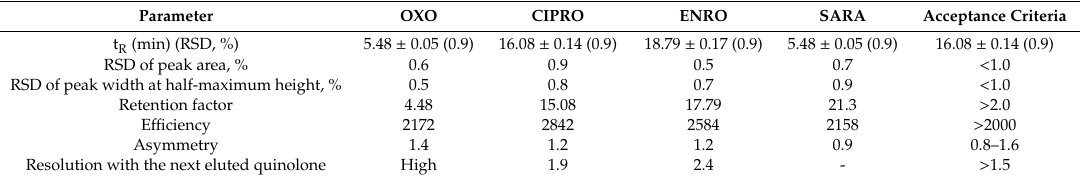
Table 1. System suitability testing. Main chromatographic parameters obtained under the optimal conditions ( n = 6). (t R : retention time; RSD: relative standard deviation; OXO, oxolinic acid; CIPRO, ciprofloxacin; ENRO, enrofloxacin; SARA, sarafloxacin). Parameter OXO CIPRO ENRO